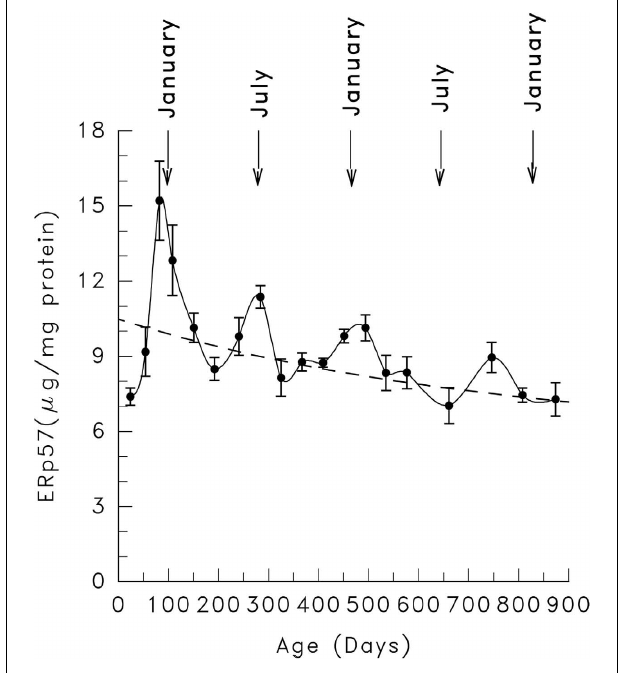
FIGURE 8 |The effect of age on the ERp57 content of rat, hepatic microsomes (taken from Erickson etal., 2006).